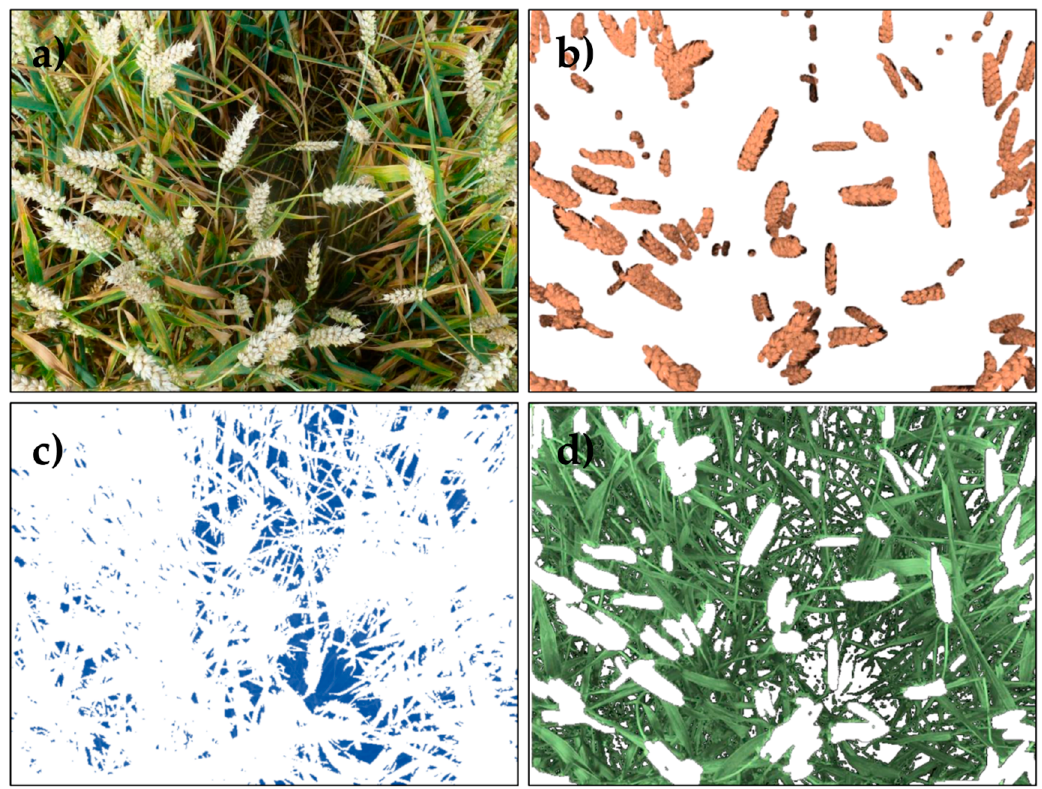
Figure 3. Illustration of the RGB image segmentation of a winter wheat canopy from 16 July 2014. From the original image ( a ), fruit ears ( b ), dark background ( c ) and leaves and stalks ( d ) are extracted.